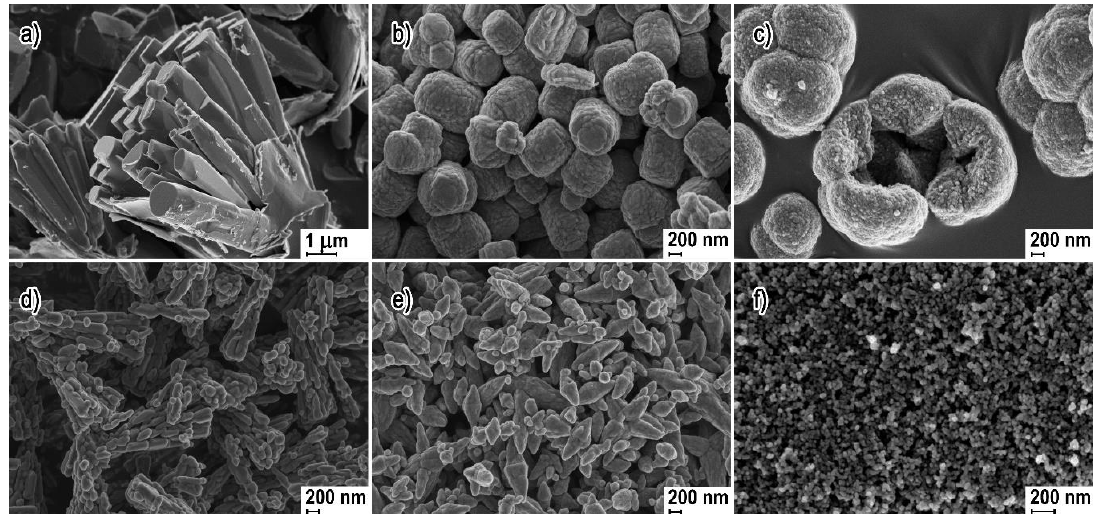
Figure 39. Examples of various ZnO structures obtained by the microwave solvothermal synthesis: ( a ) ZnO rods, ( b ) ZnO barrels, ( c ) ZnO flowers, ( d ), ZnO sticks, ( e ) ZnO irregular particles, ( f ) ZnO spherical NPs. Reprinted with permission from [496], Copyright © 2018 Dąbrowska et al., Article licensed under a CC BY 4.0, https://creativecommons.org/licenses/by/4.0/. Nanomaterials 2020 , 10 , x FOR PEER REVIEW 61 of 150